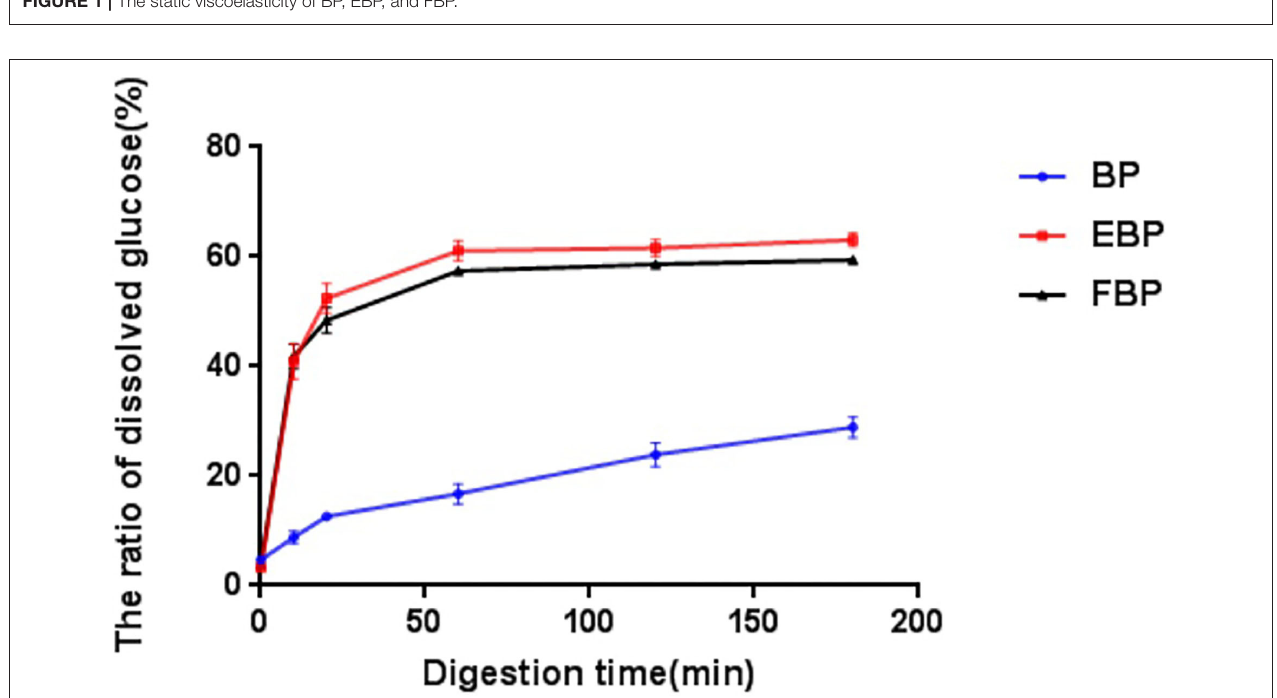
FIGURE 2 | The starch decomposition rate during digestion of BP, EBP, and FBP.